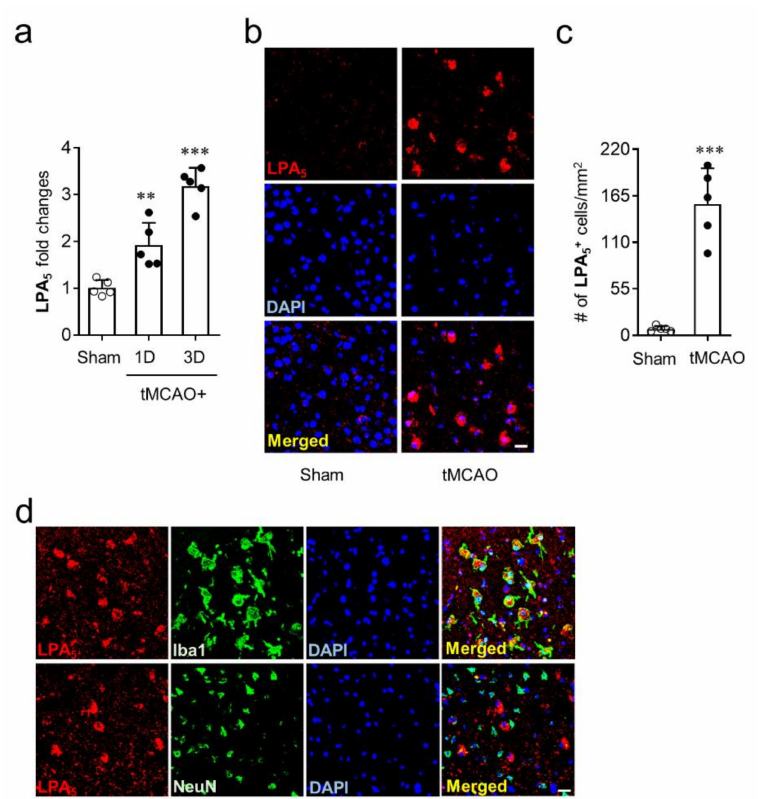
Figure 1. LPA 5 is upregulated in the ischemic core region and its upregulation occurs in activated microglial after tMCAO challenge. Ipsilateral brain samples from sham and tMCAO-operated mice were used to determine expression levels of mRNA or protein and cellular localization of LPA 5